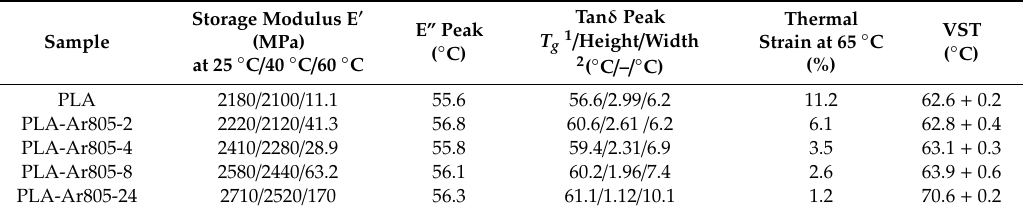
Figure 5. DMTA tests (heating rate 10 °C/min; 1 Hz) of PLA and relative nanocomposites at 2, 4, 8, and 24 vol% of FS. ( a ) Storage modulus, ( b ) loss factor (tan δ) , ( c ) thermal strain, and ( d ) coefficient of thermal expansion (CTE) below and above T g . Table 4. Results of DMTA analysis and Vicat softening temperature (VST) of PLA and relative fumed silica nanocomposites.